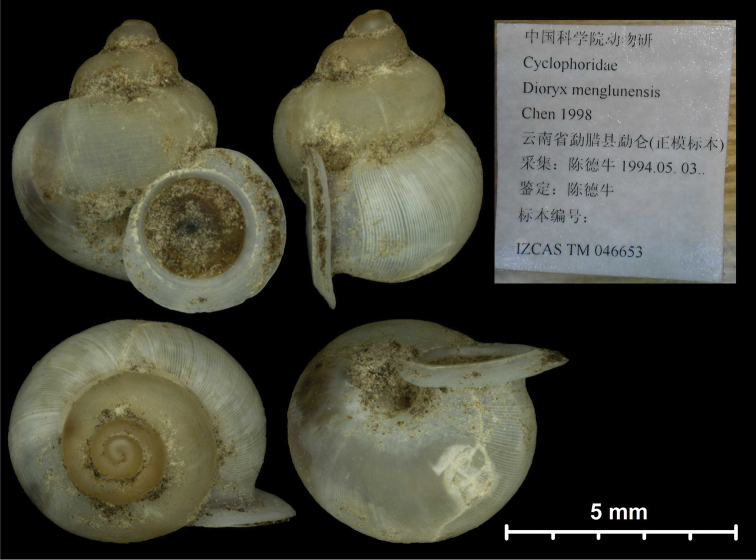
Dioryx
menglunensis Chen & Zhang, 1998, holotype (IZCAS TM 046653). Photographs: Kaibaryer Meng.